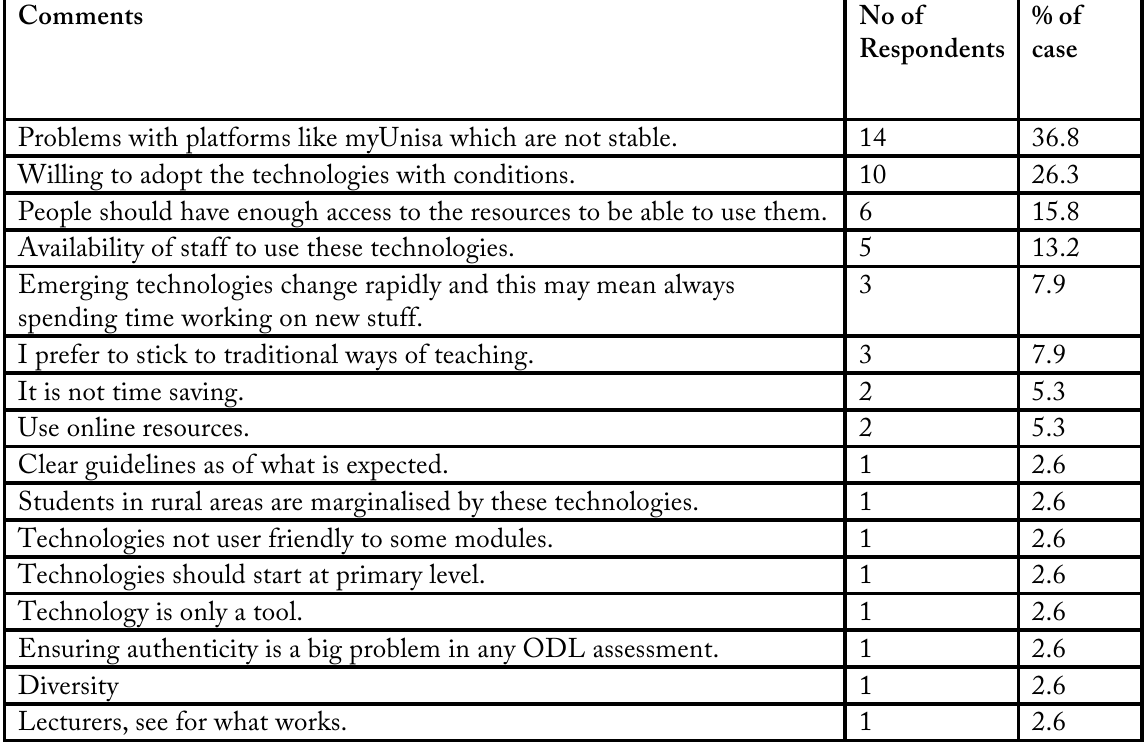
Table 9: Additional comments on readiness and willingness in adopting emerging e-learning technology (N = 53)